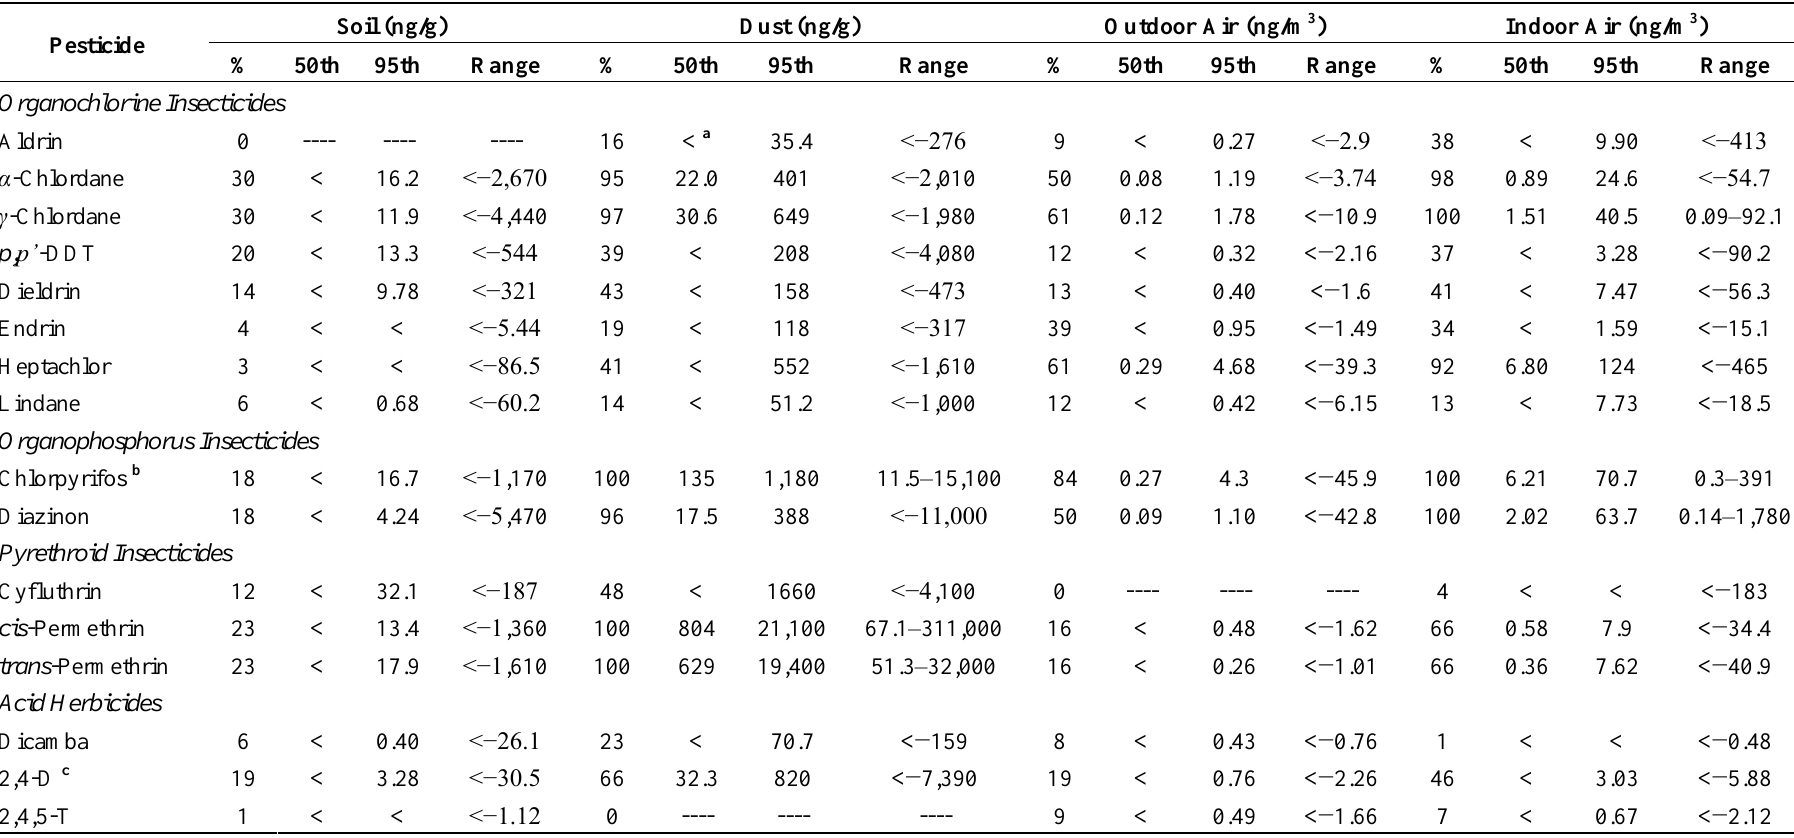
Table 3. Concentrations of pesticides in environmental media collected at 129 children’s homes in North